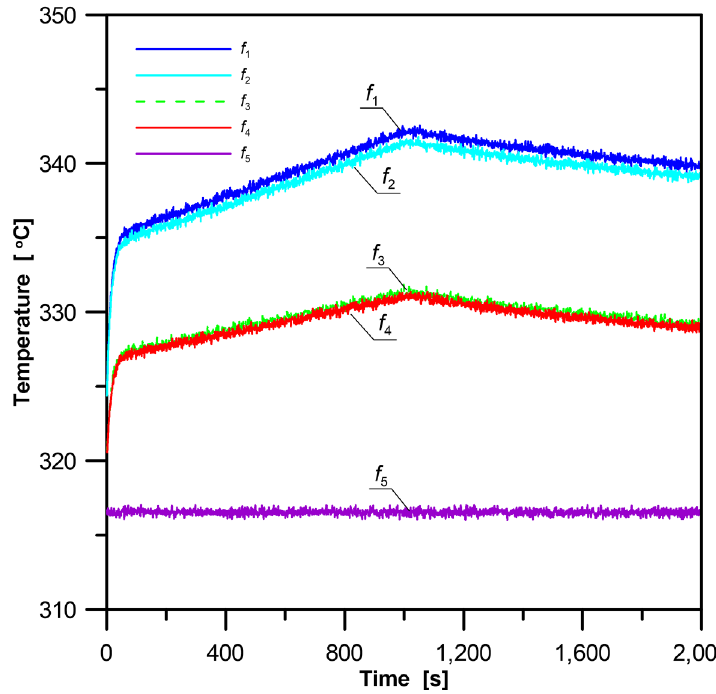
Figure 12. “Noisy measured data” generated by the FEM for the inverse solution. There were two unknown transients q m ( t ), h ( t ) and five given measured temperature transients. Vector u L consisted of two components: u 1 ( t L ) and u 2 ( t L ). The proposed method was tested with the time step of ∆ t = 10 s. The values of 0 and 100,000 <W/m 2 K, W/m 2 >, respectively, were chosen in vector u L for the lower and the upper bounds of the sought parameters. The starting vector was assumed as u L ( L = 0) = <15,000 W/m 2 K, 40,000 W/m 2 >. To reduce oscillations, the number of future time steps of N F = 20 was selected. The number of iterations in each time step ranged between 1 and 8. The estimated boundary conditions were close to the exact values, as can be seen in Figure